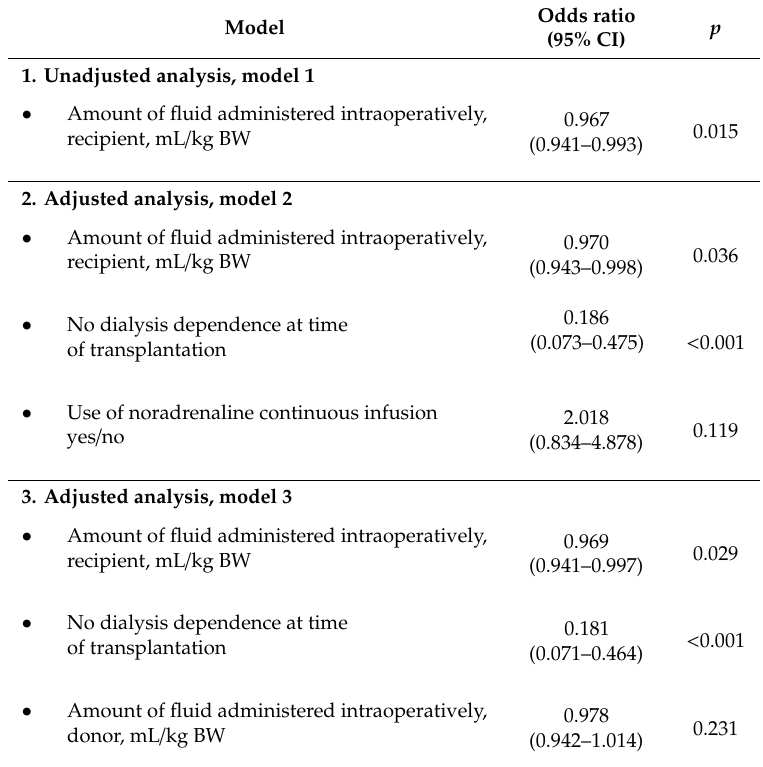
Table 3. Multivariate logistic regression on risk factors of functional delayed graft function (fDGF).